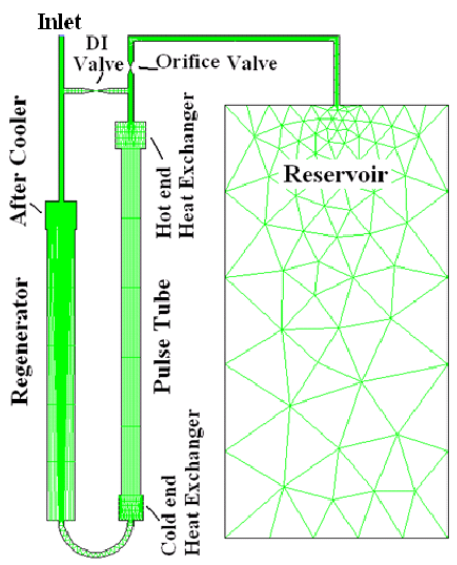
Figure 1. Geometry of GM-type double-inlet pulse tube refrigerator (DIPTR) with meshing.